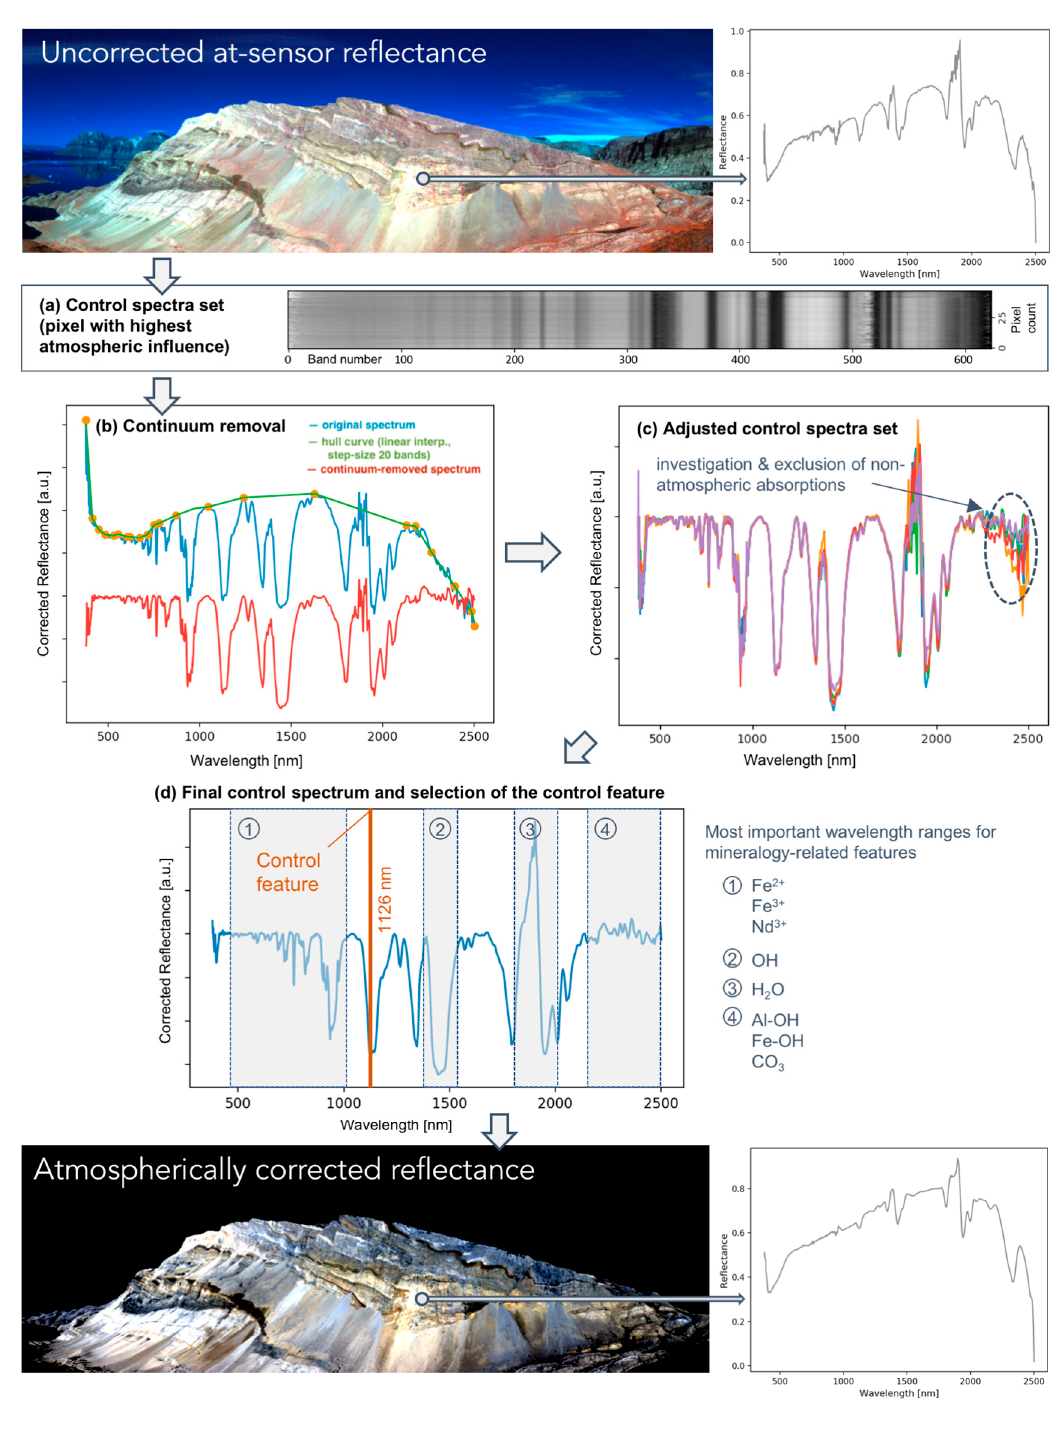
Figure 3. Atmospheric correction workflow on the example of the Maarmorilik marble cliffs (Nunngarut, Scan 2). Hyperspectral images are displayed using spectral true colour representative bands (R: 640 nm G: 550 nm B: 470 nm). See text for a detailed description. ( a ) Control spectra set; ( b ) continuum removal; ( c ) adjusted control spectra set; ( d ) final control spectrum and selection of the control feature.